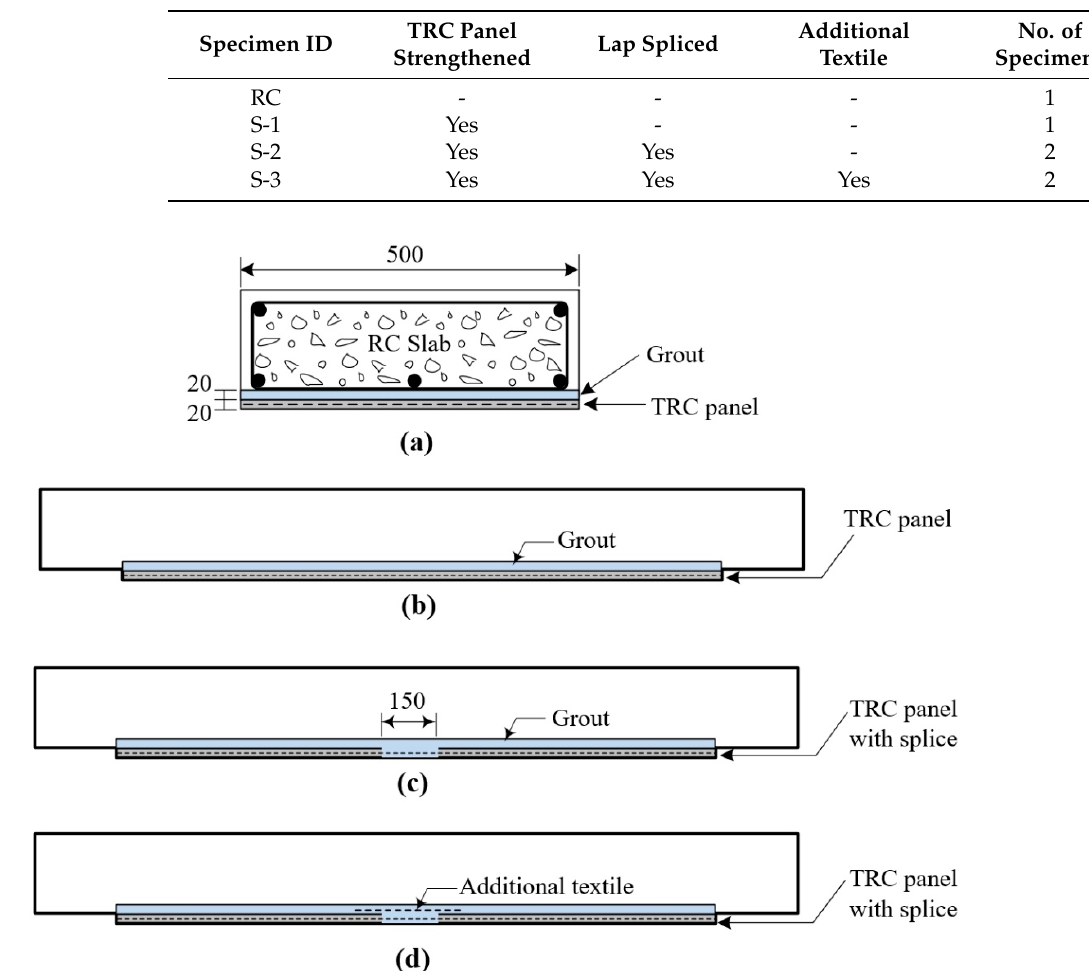
Figure 10. TRC system strengthening plan: ( a ) cross-sectional view; ( b ) TRC panel without splice; ( c ) TRC panel with a splice; and ( d ) placing additional textile at splice.